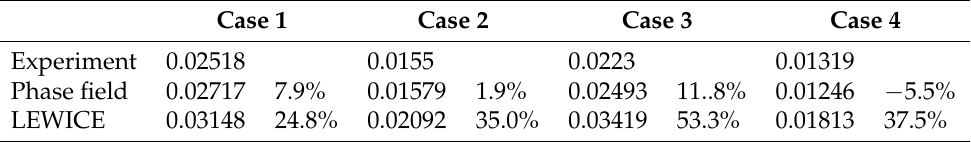
Table 2. Stagnation thickness of ice shapes provided by different icing codes and experiment.